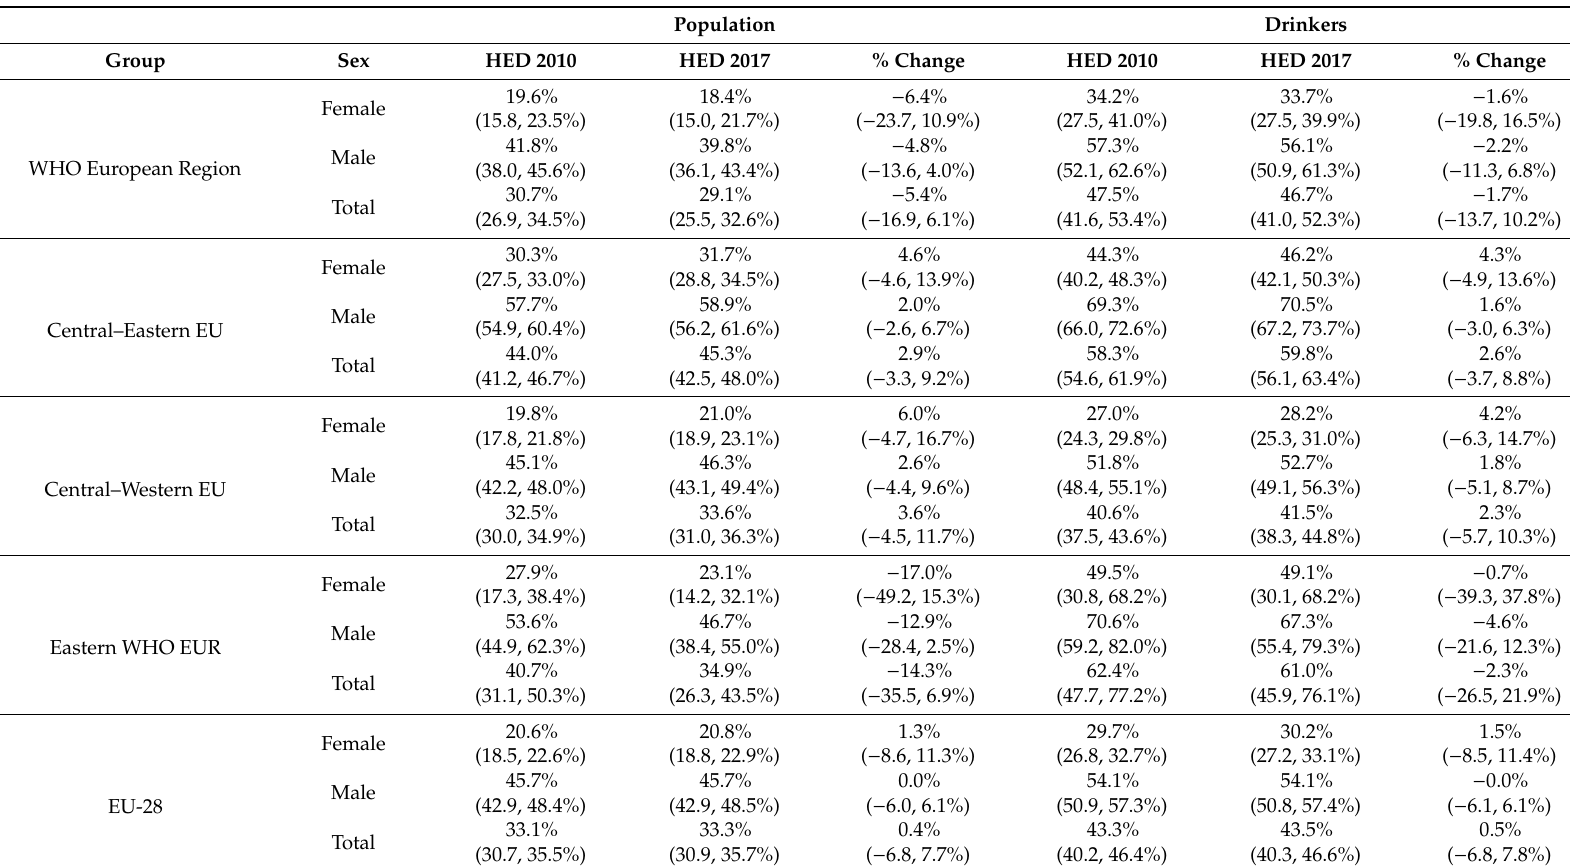
Table 3. Age-standardized prevalence of heavy episodic drinking (HED) in 2010 and 2017 and relative change in the prevalence of HED in the World Health Organization European Region and six nondisjoint country groups among the total adult population and current